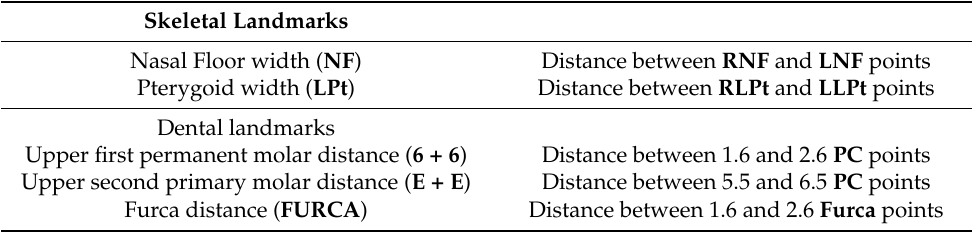
Table 3. Intraoperator error on x, y, and z axes.